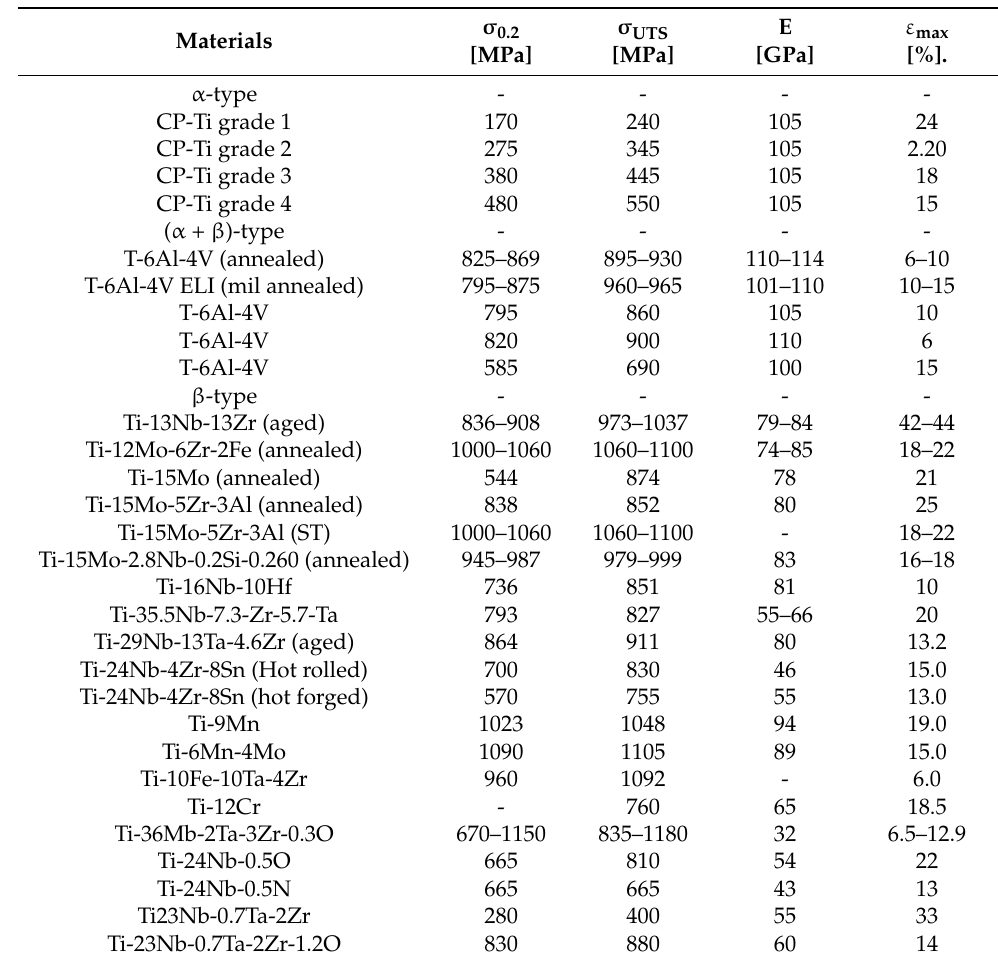
Table 1. Mechanical properties of Ti and Ti alloys for orthopedic implants. Reprinted from [5], copyright (2019), with permission from John Wiley and